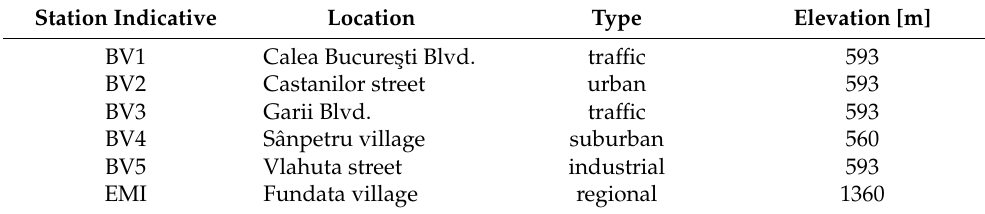
Table 2. Monitoring stations in